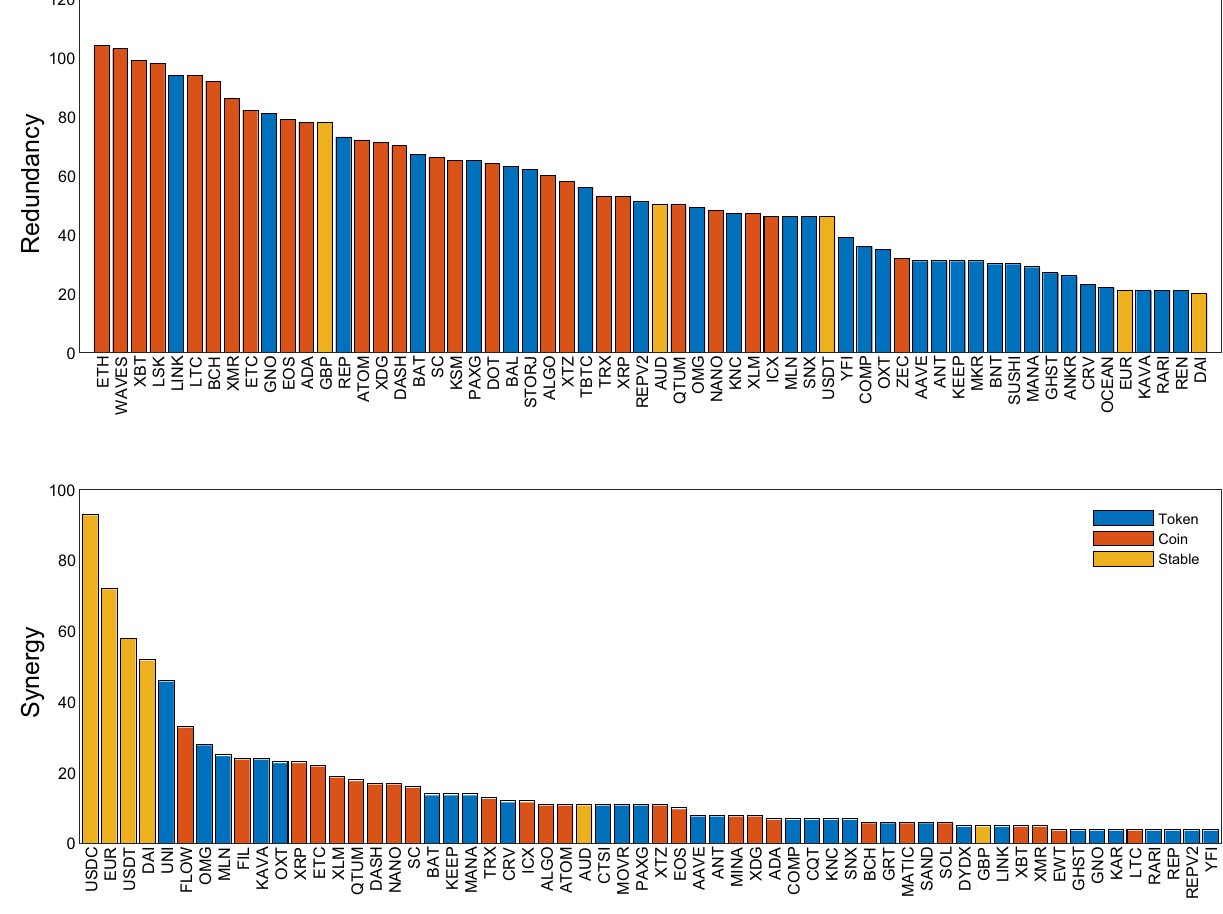
Figure 5. Most influential nodes for synergy and redundancy in the USD dataset. The bar plot counts the number of times a cryptocurrency is found in the best multiplets built as explained in the text. Yellow bars indicates stable-coins, red bars coins and blue bars tokens. Only the first 60 elements are shown.